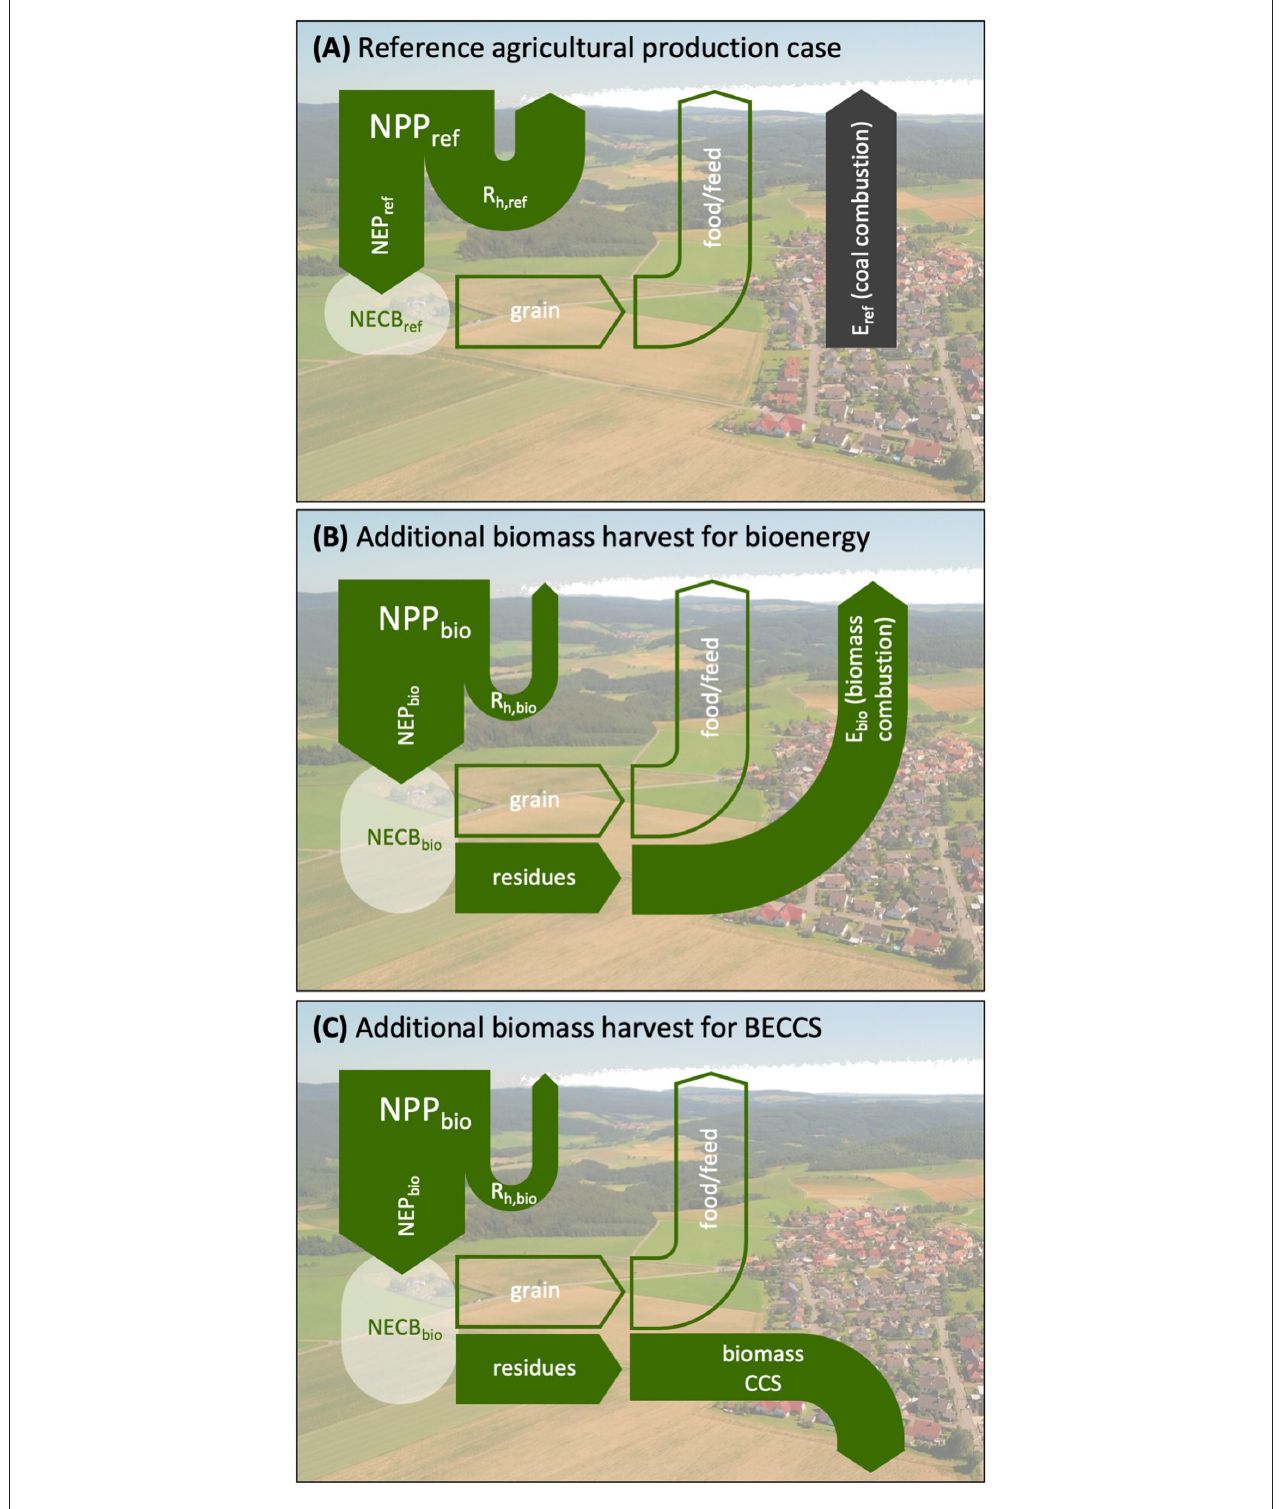
FIGURE 1 | Carbon exchanges with the atmosphere in the production of conventional and carbon-negative bioenergy (“bio”) from new agricultural residue harvest, as compared to a reference case (“ref”). Fluxes of photosynthesis-derived “biogenic” carbon are shown in green; fossil carbon emissions from fossil fuel use in black.